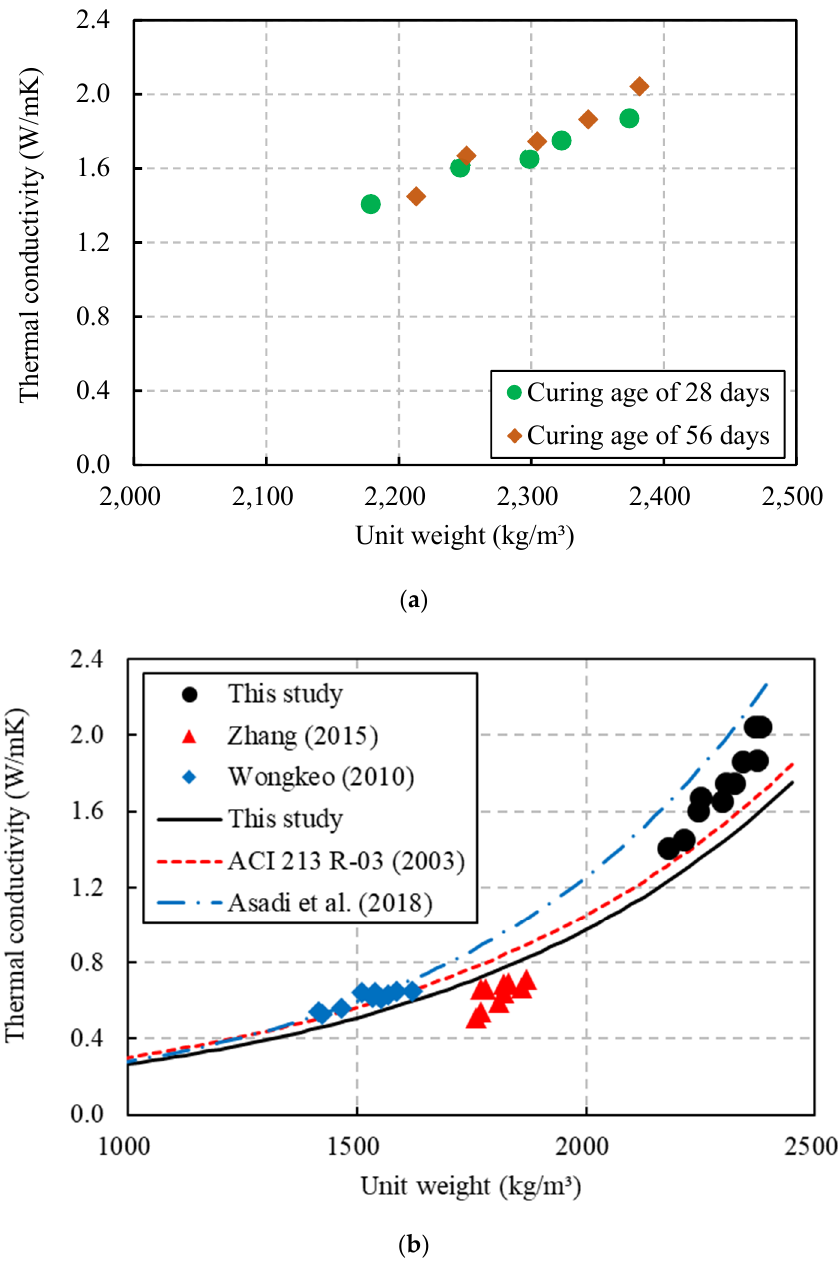
Figure 8. Relationship between the thermal conductivity and the unit weight. ( a ) Test results in this study; ( b ) comparison of the predictions in this study and previous studies